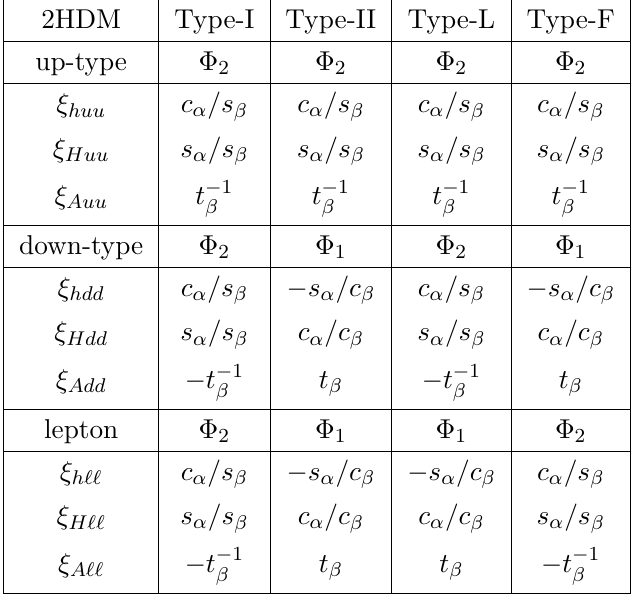
Table 1 . Types of 2HDM and the tree-level couplings of h , H and A to fermions, normalized to their SM Yukawa couplings: (cid:24) = y=y SM